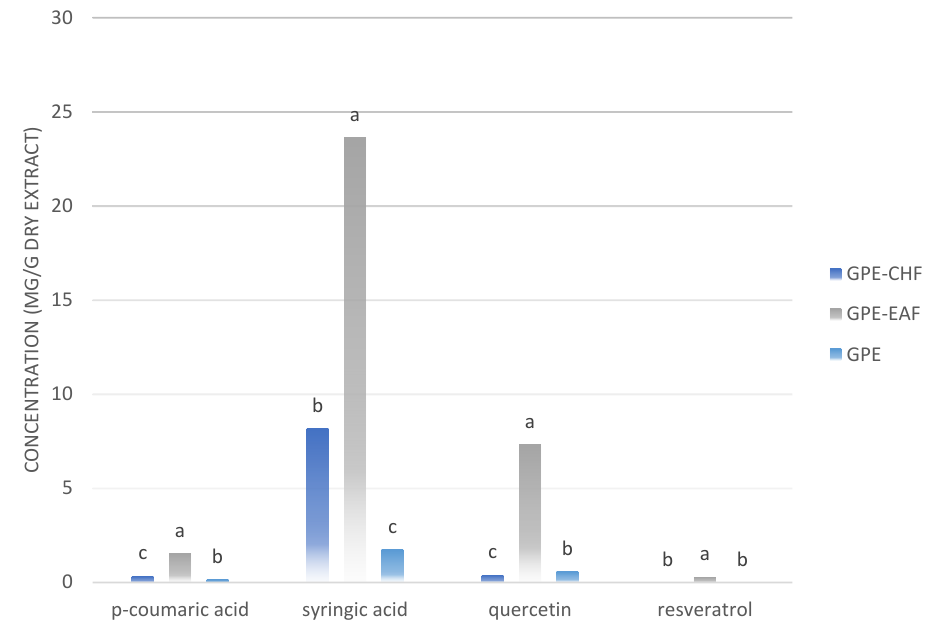
Figure 2. Polyphenols in the grape pomace extract (GPE) and in the ethyl acetate (GPE-EAF) and chloroform (GPE-CHF) fractions. Results are expressed as mean ± standard deviation. In each group, different letters (a, b, and c) indicate significant differences ( p < 0.05).